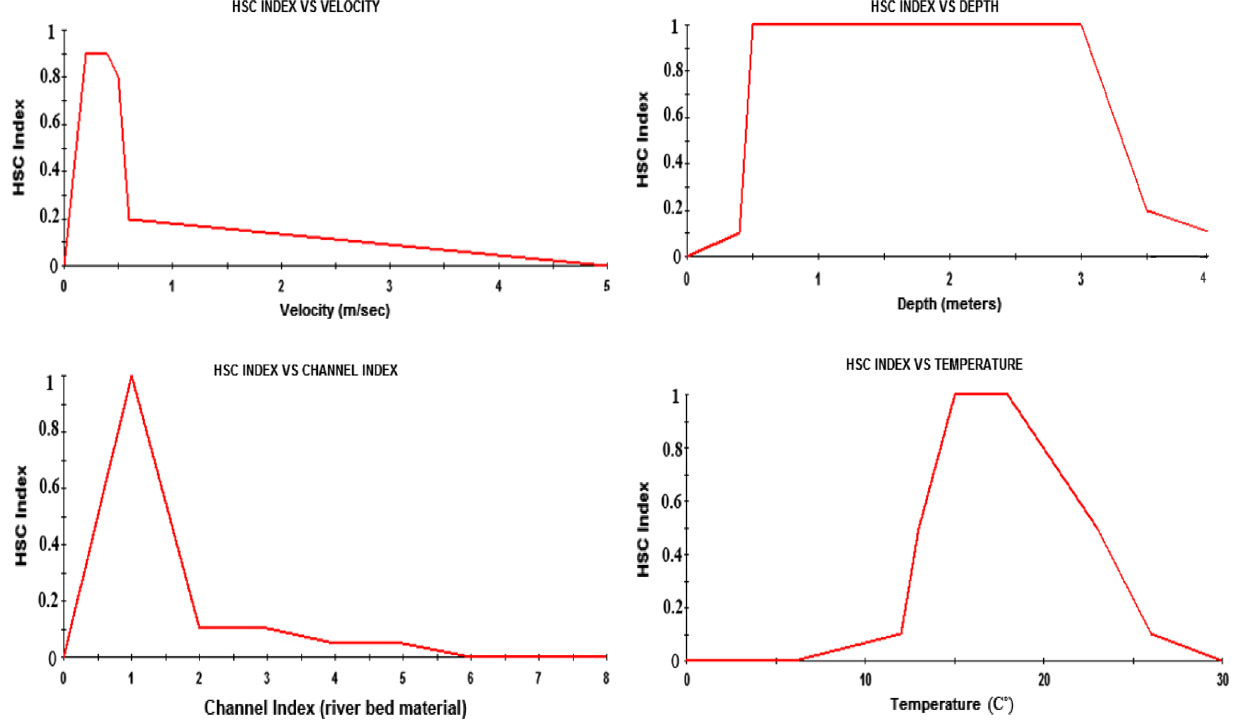
Fig. 6 Habitat Sustainability Curve for the Cyprinus carpio fish during spawning stage in the Qarasu river (channel index or the river bed mate-